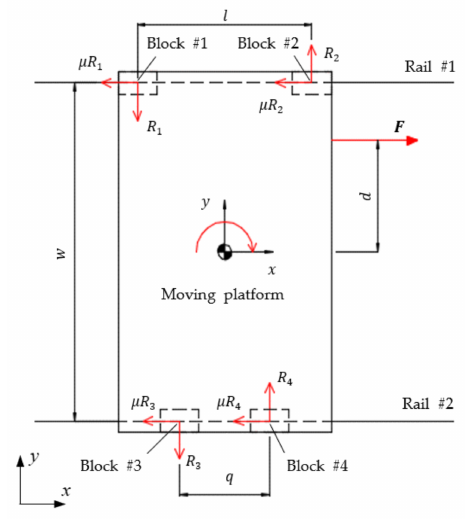
Figure 4. Free body diagram of the moving